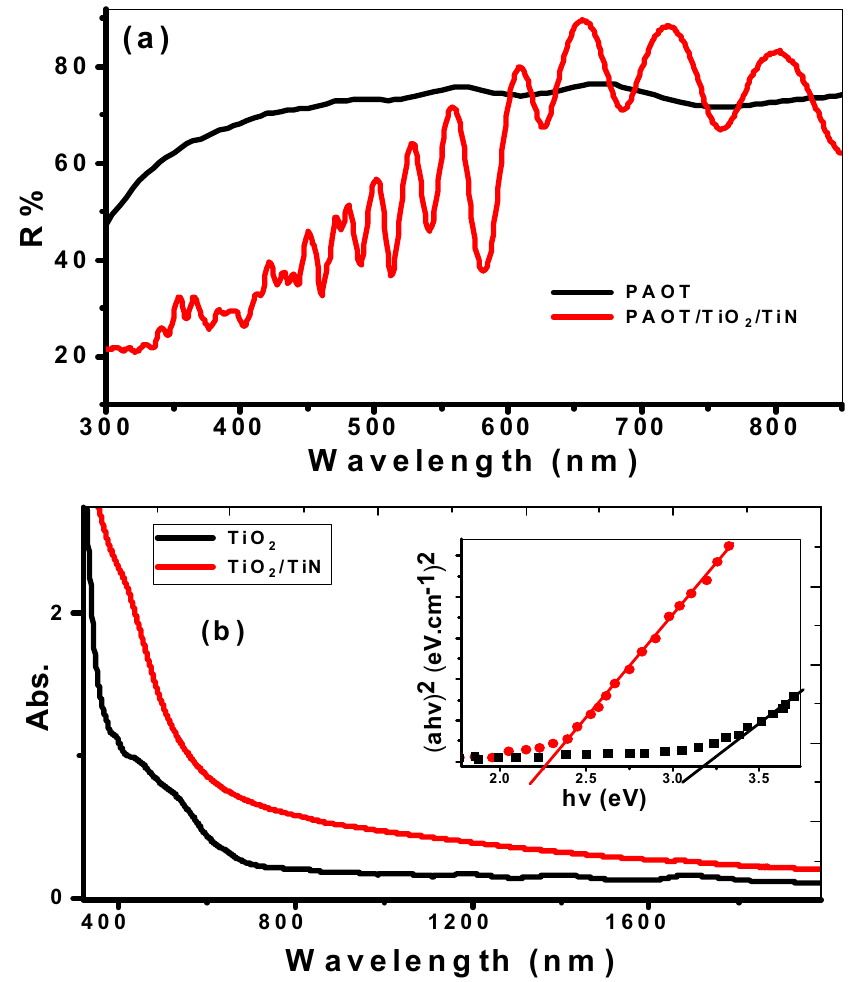
Figure 4. Optical properties of TiO 2 and TiO 2 /TiN; ( a ) reflection and ( b ) absorption spectra. The inset of ( b ) shows ( α h ν ) 2 versus h ν for energy gap